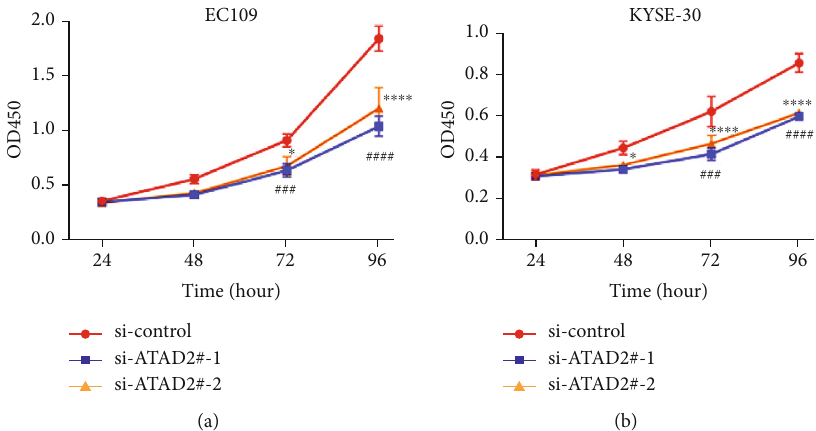
Figure 3: ATAD2 silencing reduces the proliferation ability of ESCC cells. (a and b) Cell proliferation rate evaluated by CCK-8 proliferation analysis. The two-way ANOVA test was adopted for comparison among multiple groups, followed by Dunn ’ s multiple-comparison test. ∗ P < 0 : 05 , ∗∗∗ , ### P < 0 : 001 , ∗∗∗∗ , #### P < 0 : 0001 .